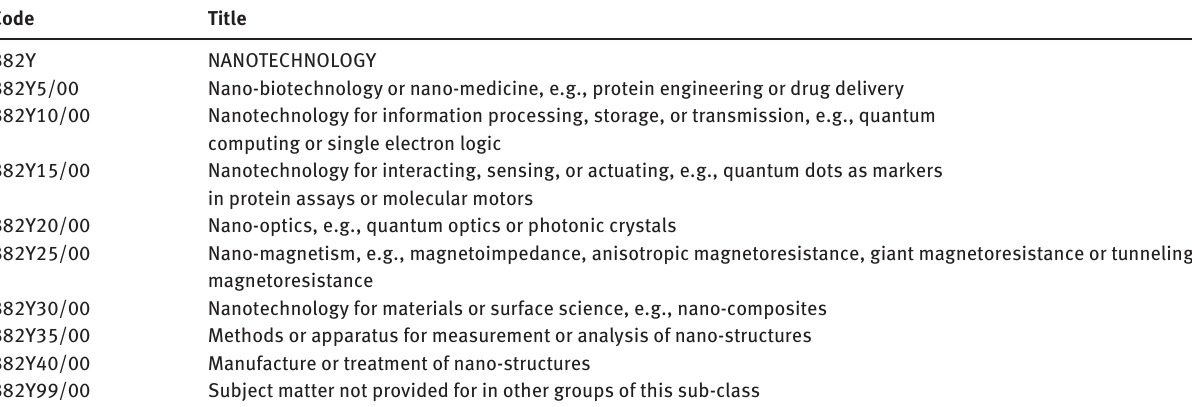
Table 1 Nanotechnology subclasses in the International Patent Classification.